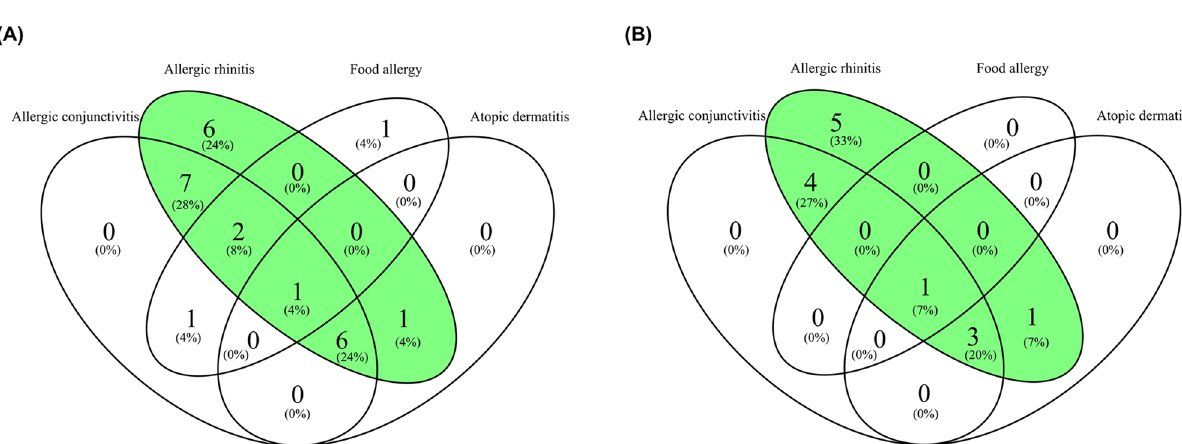
Figure 4. Coexistence of atopic conditions in women with asthma. ( A ) Venn diagram of the coexistence of atopic conditions in women with asthma in Group 1. ( B ) Venn diagram of the coexistence of atopic conditions in women with asthma in Group